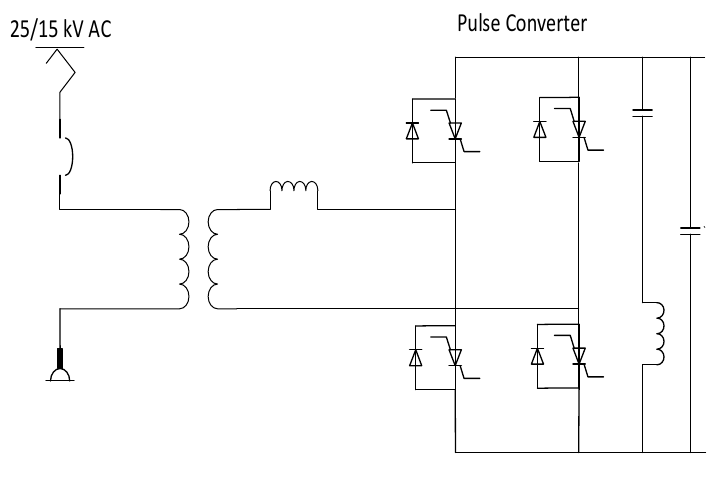
Figure 13. AC-fed VSI.